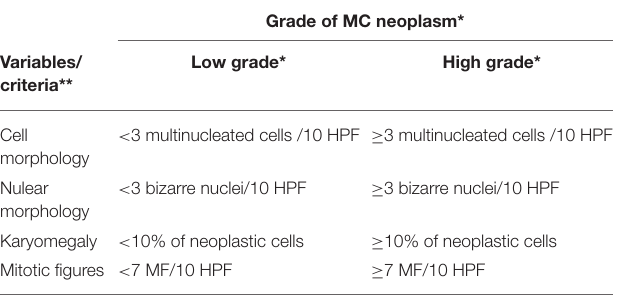
TABLE 2 | Proposed grading criteria for canine mast cell (MC) neoplasms